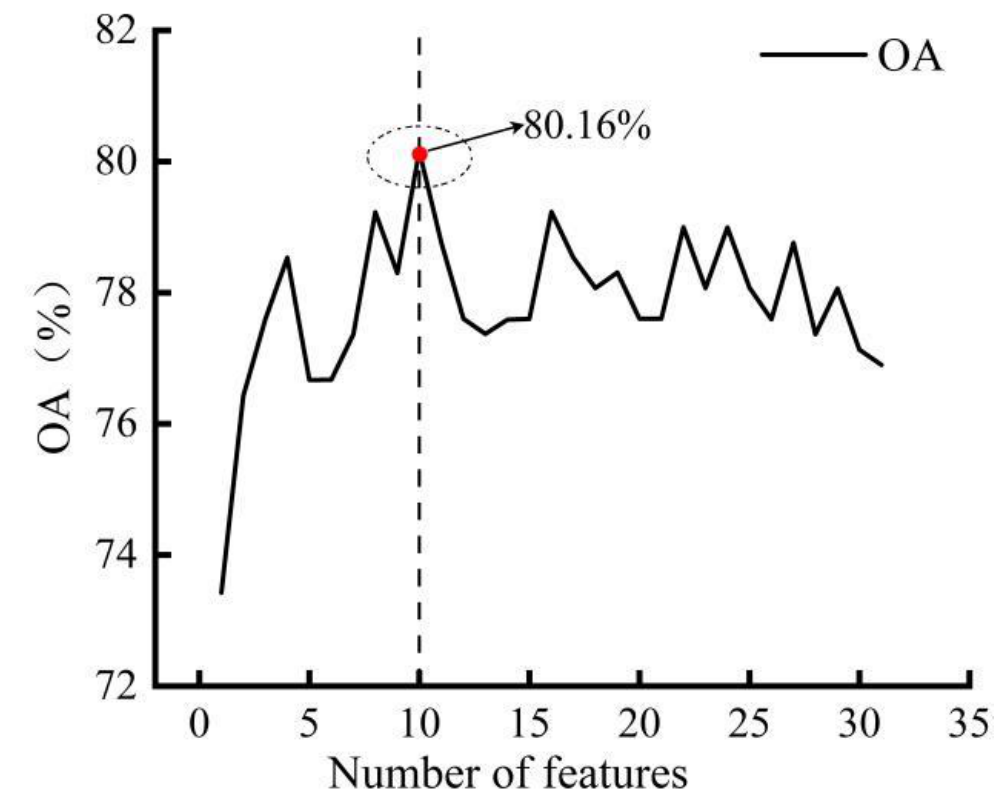
Figure 3. RF-RFE feature selection. The red dot inside the circle represents the overall accuracy (OA) corresponding to the optimal number of feature dimensions, i.e., 80.16%.